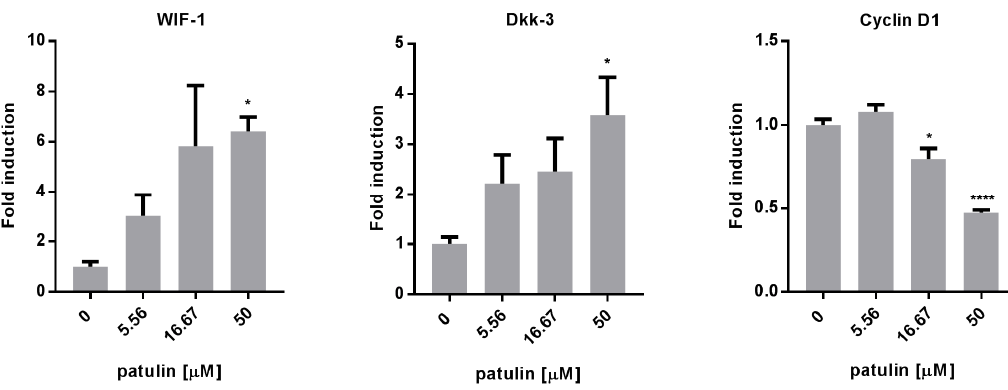
Figure 5 . Patulin inhibited the Wnt pathway. RT-qPCR analysis showed that a 24 h treatment with patulin upregulated the expression of WIF-1 and Dkk-3, two endogenous inhibitors of the Wnt pathway, and downregulated Cyclin D1, a target gene of this pathway. * p < 0.05, **** p < 0.0001.